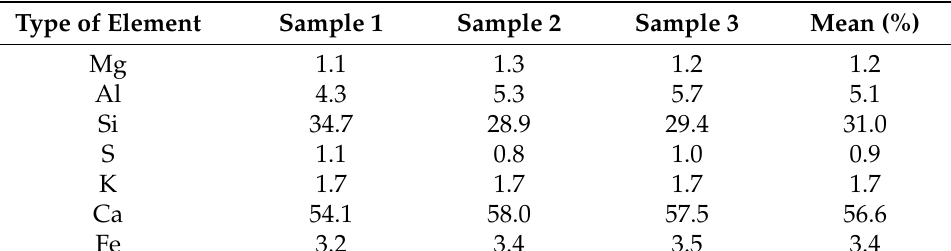
Table 9. Element compositions of samples taken from the center layer of the concrete structure as determined by EDS. Figure 6. SEM images of the samples taken from center layer of the concrete structure: ( a ) ×10,000; ( b ) ×5000.